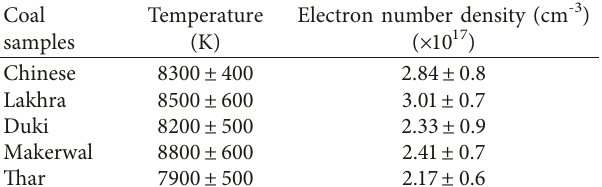
Table 1: Plasma temperature and electron number densities of the coal samples.